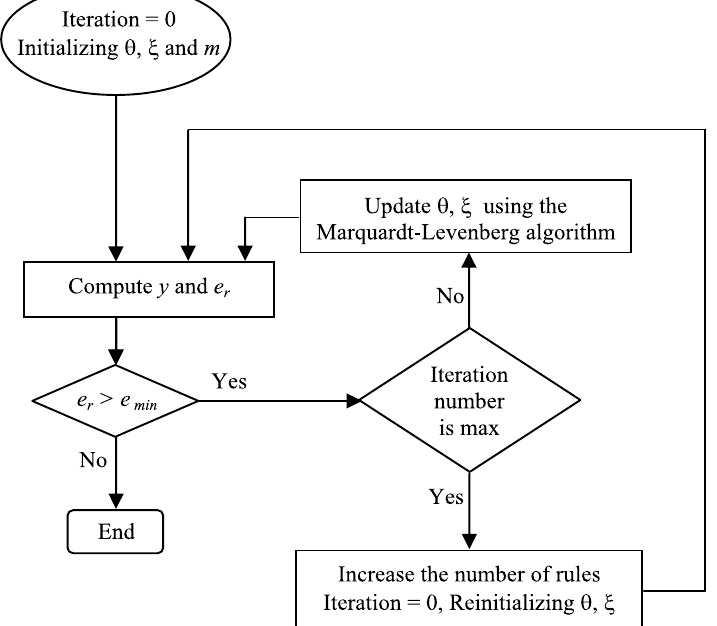
Fig. 1. The proposed T-S Fuzzy model identi fi cation